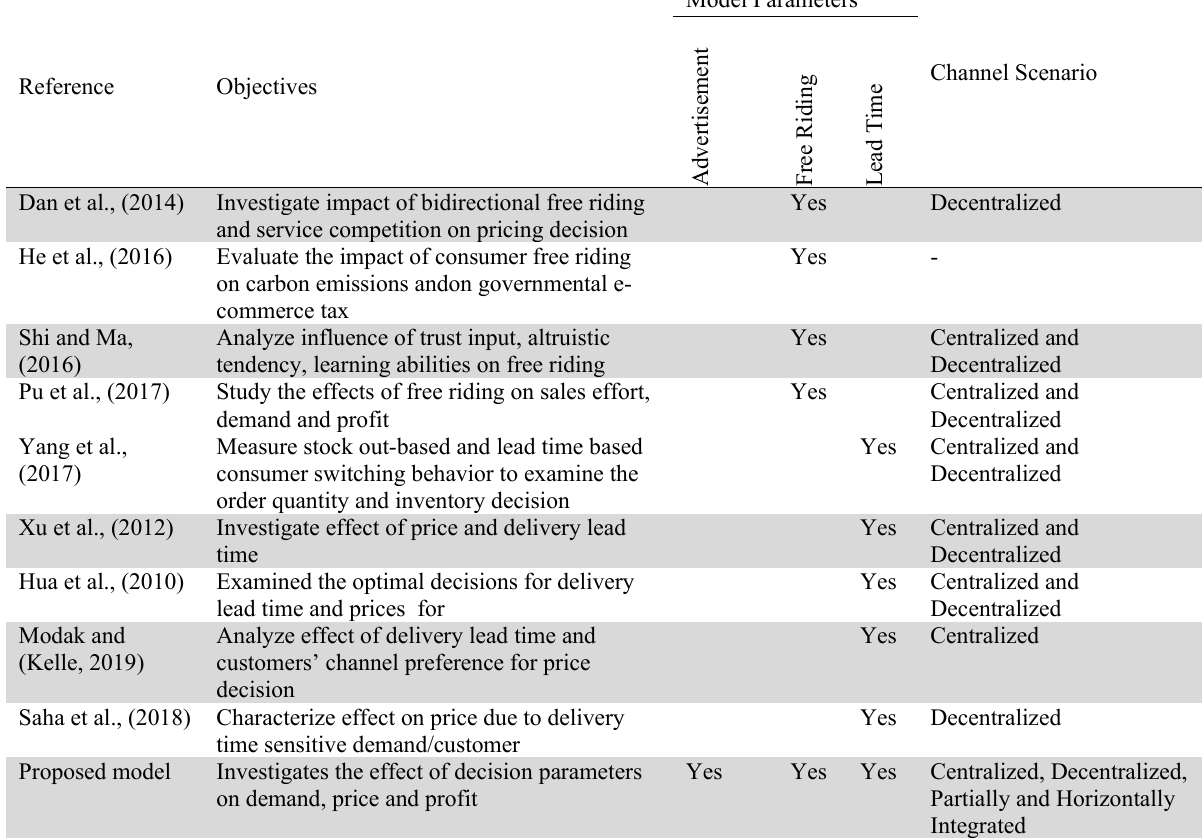
A comparison of current model with existing dual supply chain models